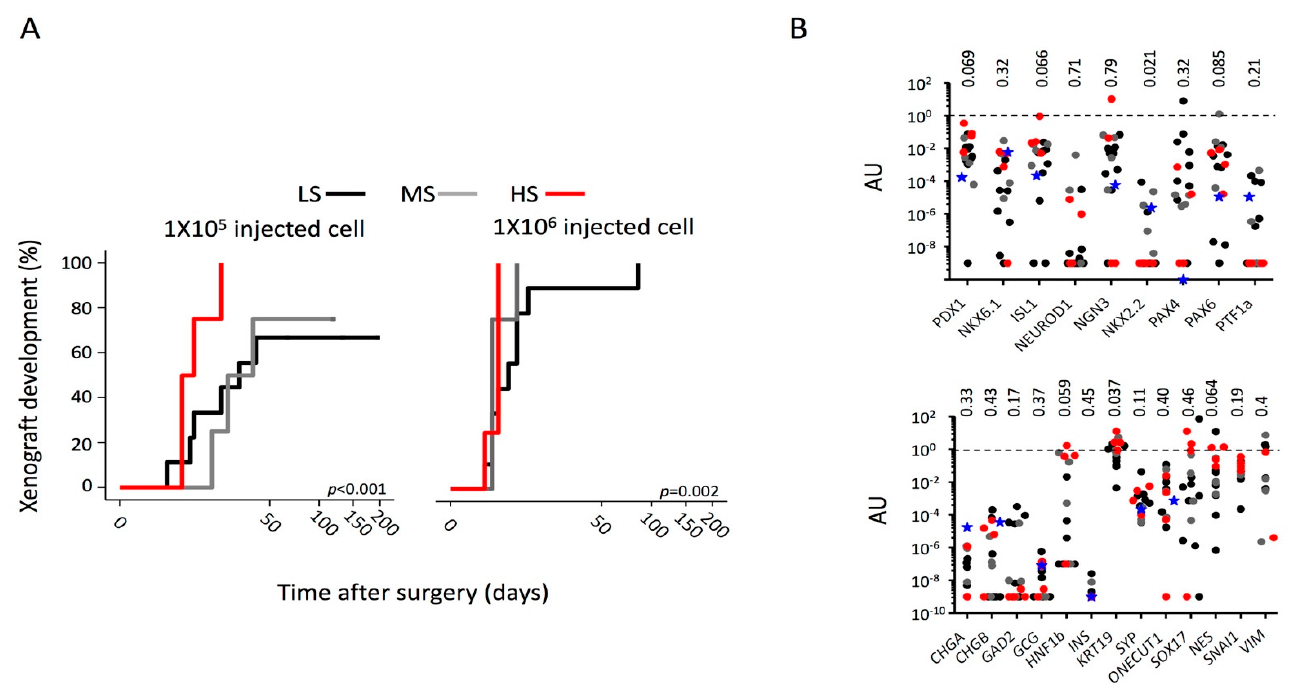
Figure 3. Tumorigenicity of PDAC cell lines and gene expression profile according to the differ- ent stemness degrees. ( A ) Kaplan–Meier curve estimating the cumulative probability to develop xenograft of the 17 PDAC cell lines injected in CD1 nude mice according to the different stemness degrees. Shown is the p -value estimated by the log-rank test. ( B ) Gene expression analysis of tran- scription factors involved in embryonic pancreatic development and markers of terminal cell fate by qRT-PCR. Each dot represents a line. Black dot: Low-Stemness lines; Grey dot: Medium-Stemness lines; red dot: High-Stemness lines; blue star: normal human pancreatic duct cell line HPDE6-E6E7. The Kruskal–Wallis test with post hoc Dunn’s multiple comparison test was applied.